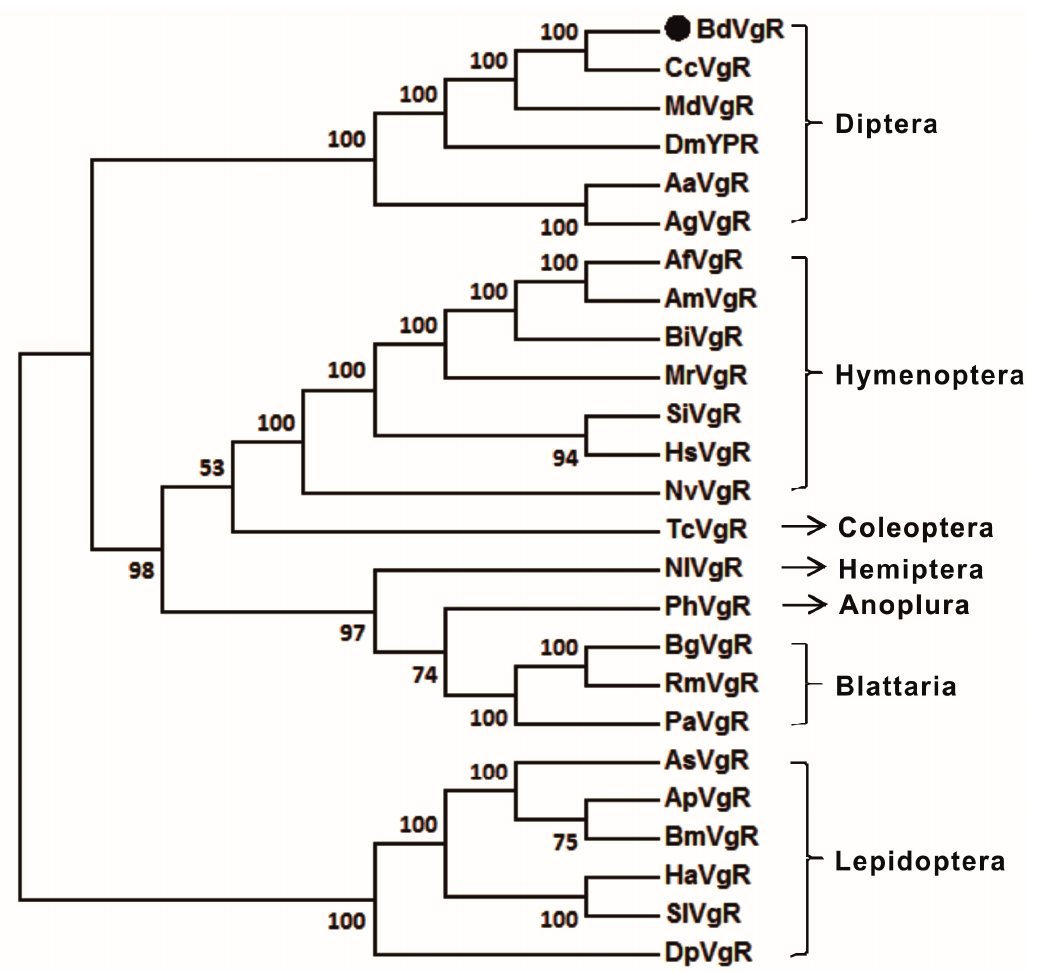
Figure 2. A phylogenetic tree of vitellogenin receptors. The amino acid sequences of Bd VgR 24 and other insect VgR sequences were selected to analyze the evolutionary relationship using the Neighbor-Joining method with a bootstrap value of 1000. The dot stands for protein sequence of VgR from B. dorsalis